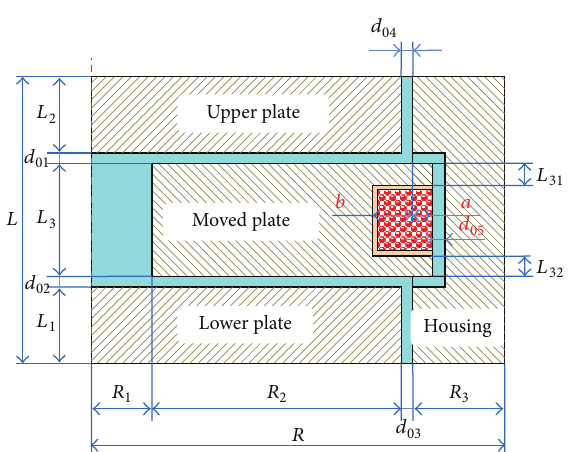
Figure 24: Section of MR valve with changeable damping gaps of mount.